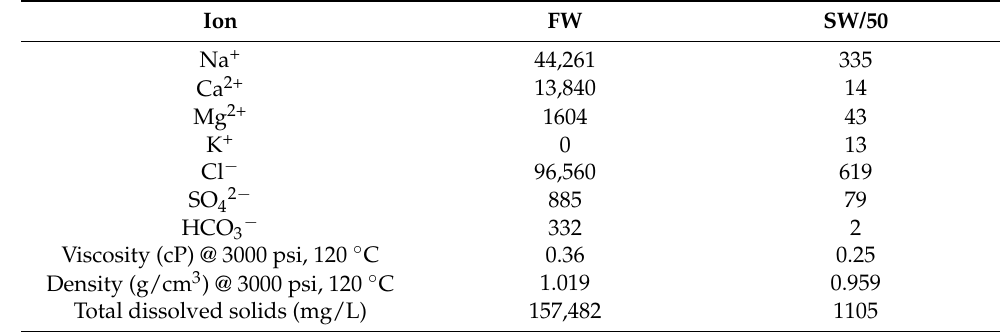
Table 1. Ionic composition (mg/L), viscosity and density of formation water (FW), and